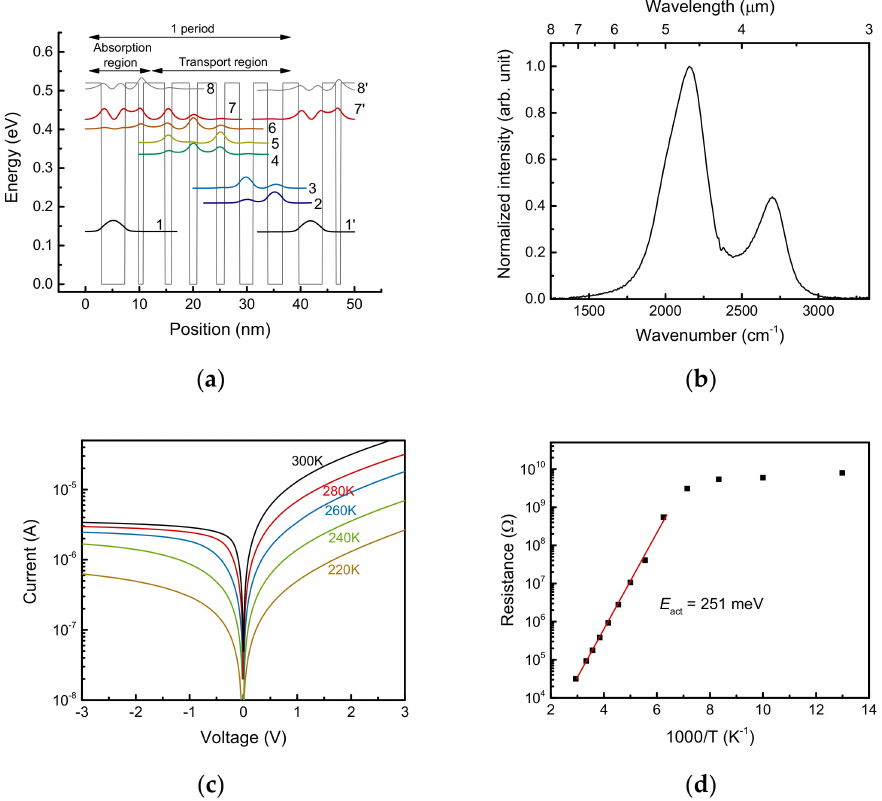
Figure 1. ( a ) Schematic of the conduction band and moduli squared of the relevant wave- functions of the quantum cascade detector. The In 0.53 Ga 0.47 As/In 0.52 Al 0.48 As layer sequence of one period of the active regions, in angstroms, starting from the absorption well, is 44/ 25 /9/ 40 /13/ 33 /14/ 36 /15/ 28 /25/ 27 /28/ 30 , where InAlAs barrier layers are in bold, InGaAs quantum-well layers are in roman type, and the doped layer (Si, 4 × 10 17 cm − 3 ) is underlined. ( b ) Photoresponse spectrum of the device measured without cooling. ( c ) Dark current–voltage characteristics over the temperature range 220–300 K. ( d ) Arrhenius plot of the measured differential resistance. The red line is the fit of the Arrhenius model, L = Aexp[ E act / k B T ], where L is lifetime, A is a constant, E act is the activation energy, k B is Boltzmann’s constant, and T is the device